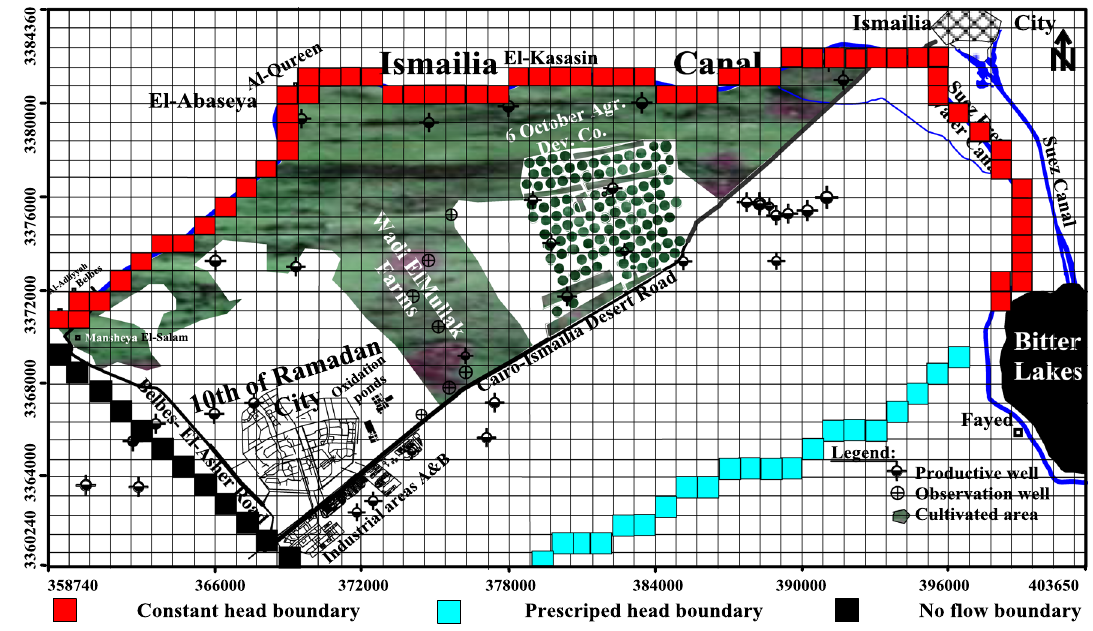
Fig. 5 Model domain grid and the boundary conditions of the simulated Quaternary aquifer. (ELnemr et al.